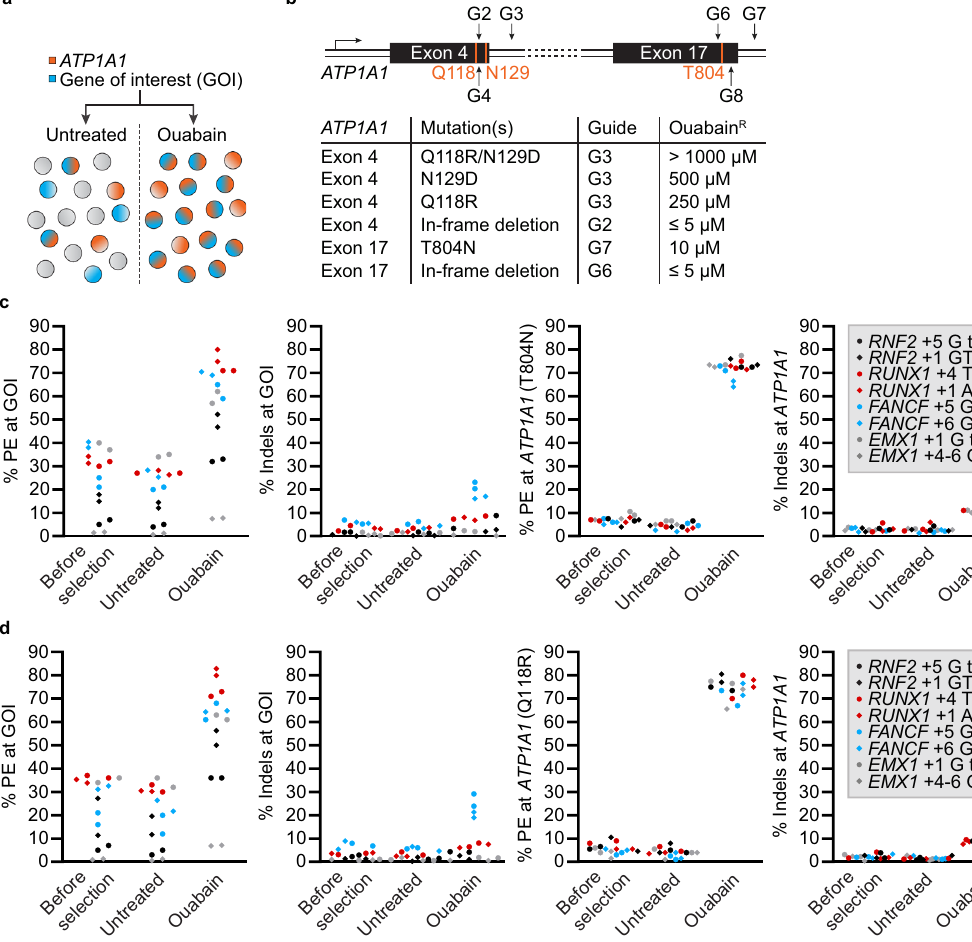
targeting ATP1A1 exon 17 (T804N) and the indicated GOI. Genomic DNA was har- vested 3days post-transfection (before selection) and cells were treated (ouabain) ornot(untreated)with0.5 µ Mouabainuntilallnon-resistantcellswereeliminated. d Same as in c but co-targeting was performed via ATP1A1 exon 4 (Q118R). n =2 independent biological replicates performed at different times. Source data are provided in the Source Data fi